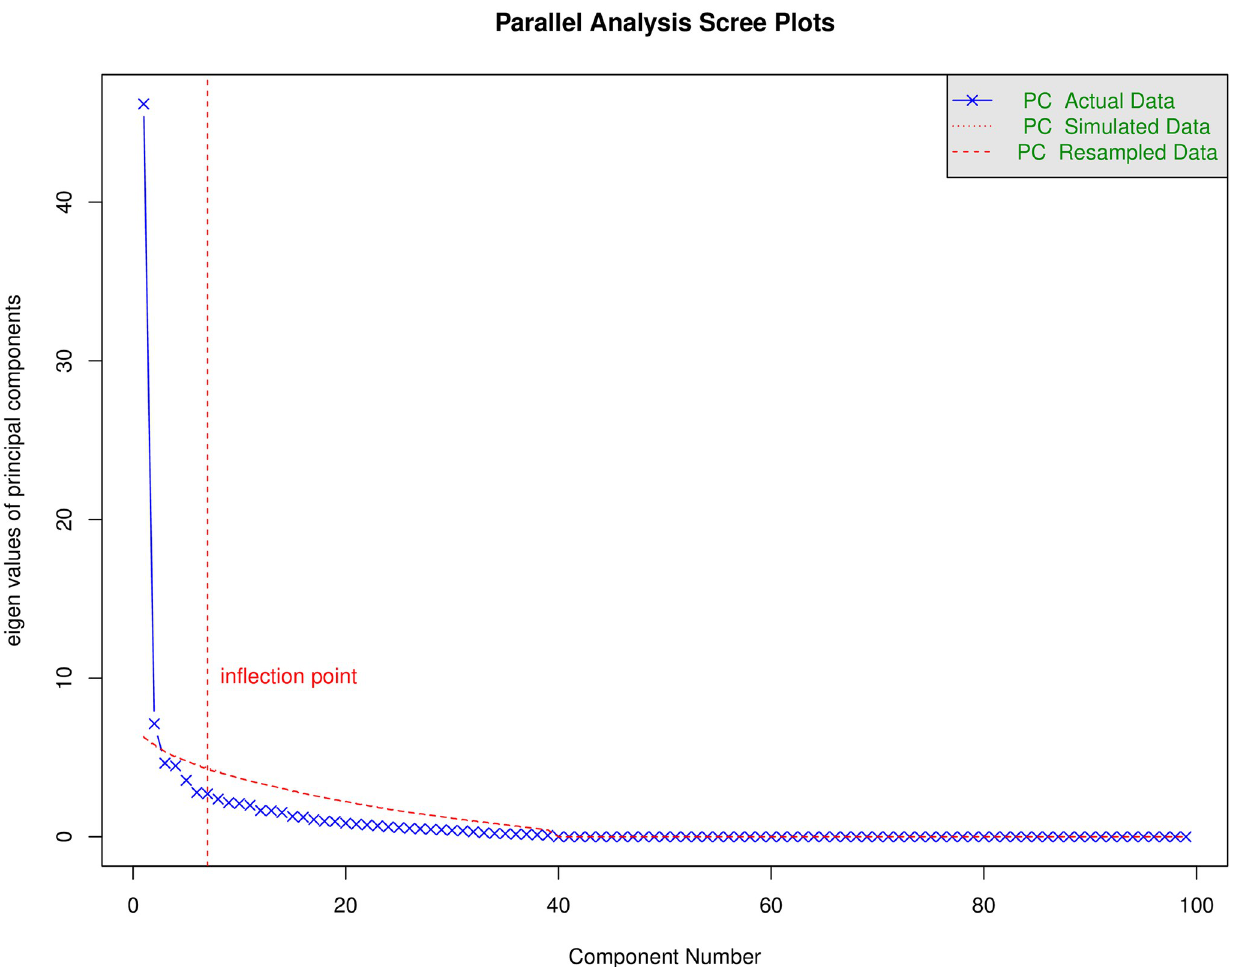
Fig 3. Principle component analysis. The blue and red curves represent the real and simulated